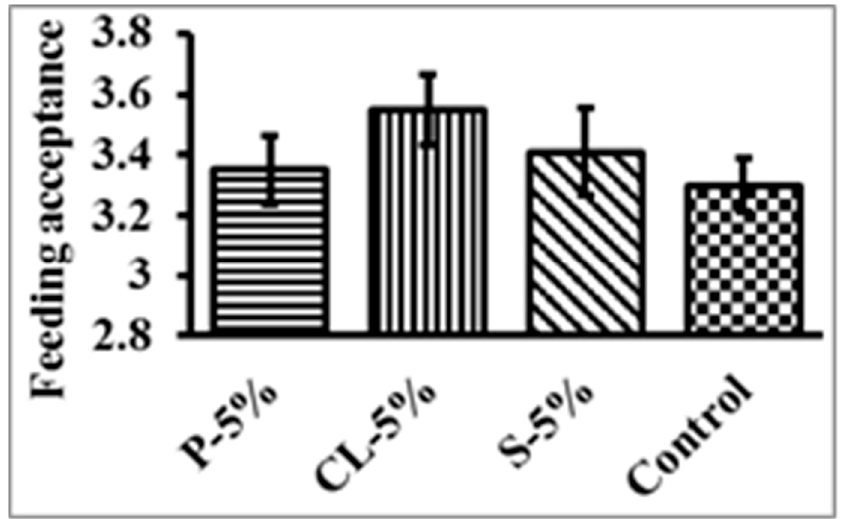
Figure 3. Feeding acceptance test of different types of gel feed by Puntius conchonius. *Data are represented as mean ± SE. Different superscripts indicate statistically significant differences ( p <0.05) among the experimental groups.